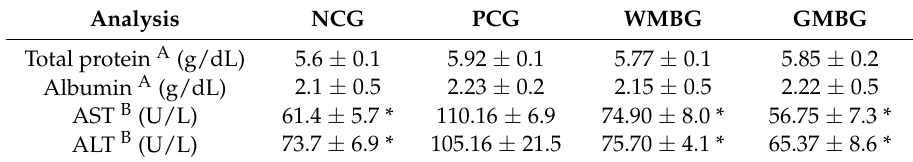
Table 4. Total proteins, albumin, aspartate aminotransferase (AST), alanine aminotransferase (ALT) in negative control (NCG), positive control (PCG), and whole (WMBG) and germinated (GMBG) mung bean